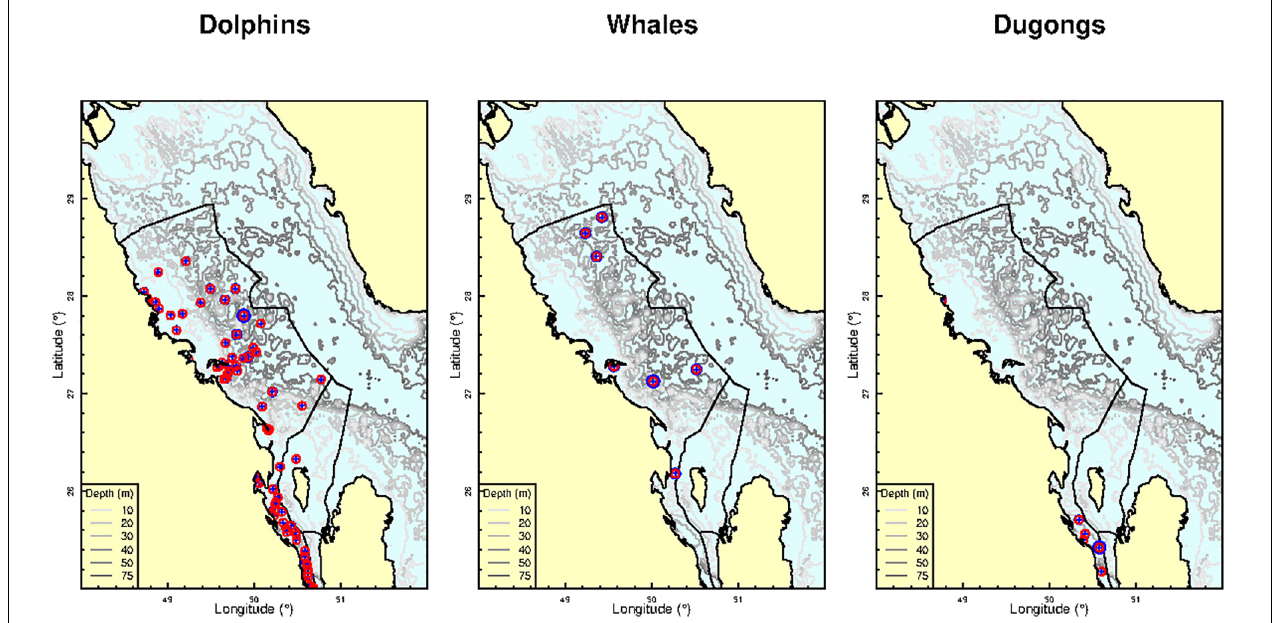
FIGURE 4 | Opportunistic sightings of three mammal groups (Dolphins, Whales, Dugongs) in Saudi waters of the Arabian Gulf between February 18, 2016 and October 2, 2020 (blue cross), circular vicinity of 5 km radius (red circle) and the location of oil and gas facilities (black dots).